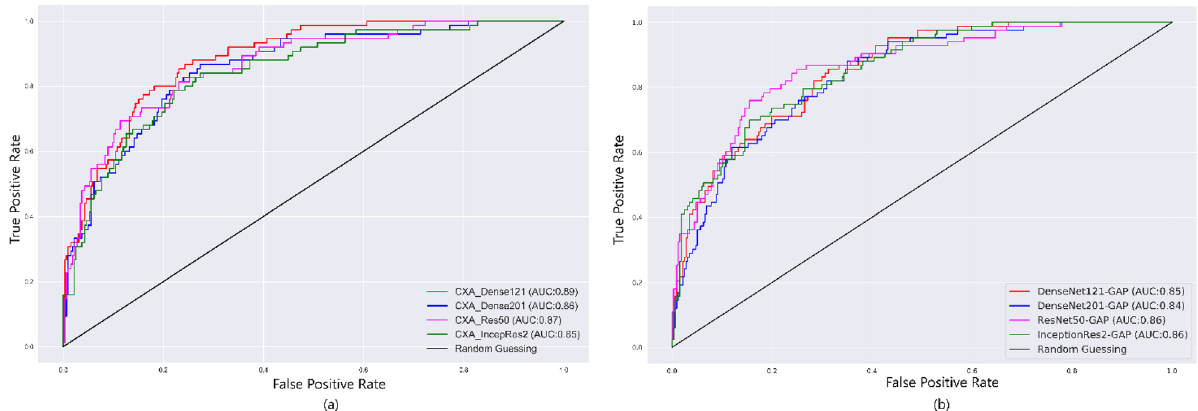
Figure 6. Comparison of ROC curves under Test dataset ( a ) for CXA_Dense121, CXA_Dense201, CXA_IncepRes2 and CXA_Res50; and ( b ) for DenseNet121-GAP, DenseNet201-GAP, ResNet50-GAP, and